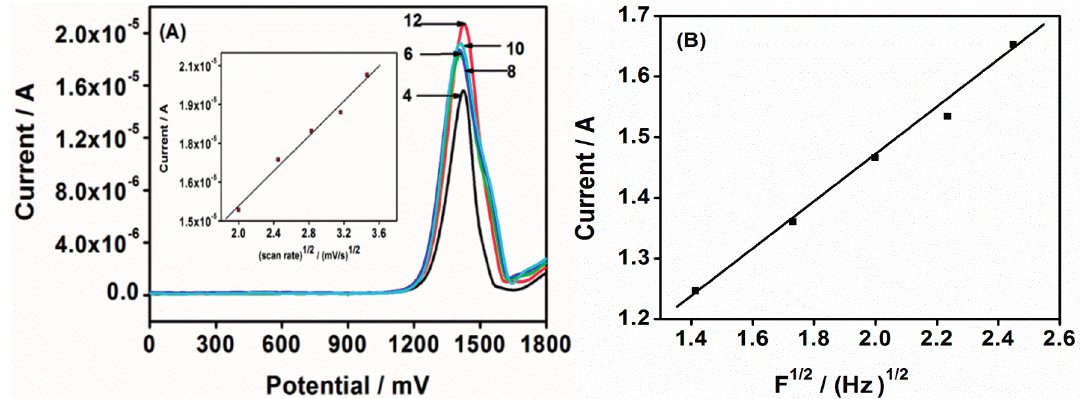
Figure 5. AC voltammograms ( A ) Scan rate dependence of Au|G3PPT-co-P3HT sensor recorded in the absence of PHE in 0.1 mol/L Bu 4 NClO 4 /CH 3 CN (experimental conditions were: the SW frequencies of the scan rates (mV/s) were 2 (4), 3 (6), 4 (8), 5 (10), and 6 Hz (12); and the other experimental conditions were: SW amplitude E sw = 25 mV and scan increment E s = 2 mV); ( B ) The dependence of peak current on the square root of the frequency for Au ǀ